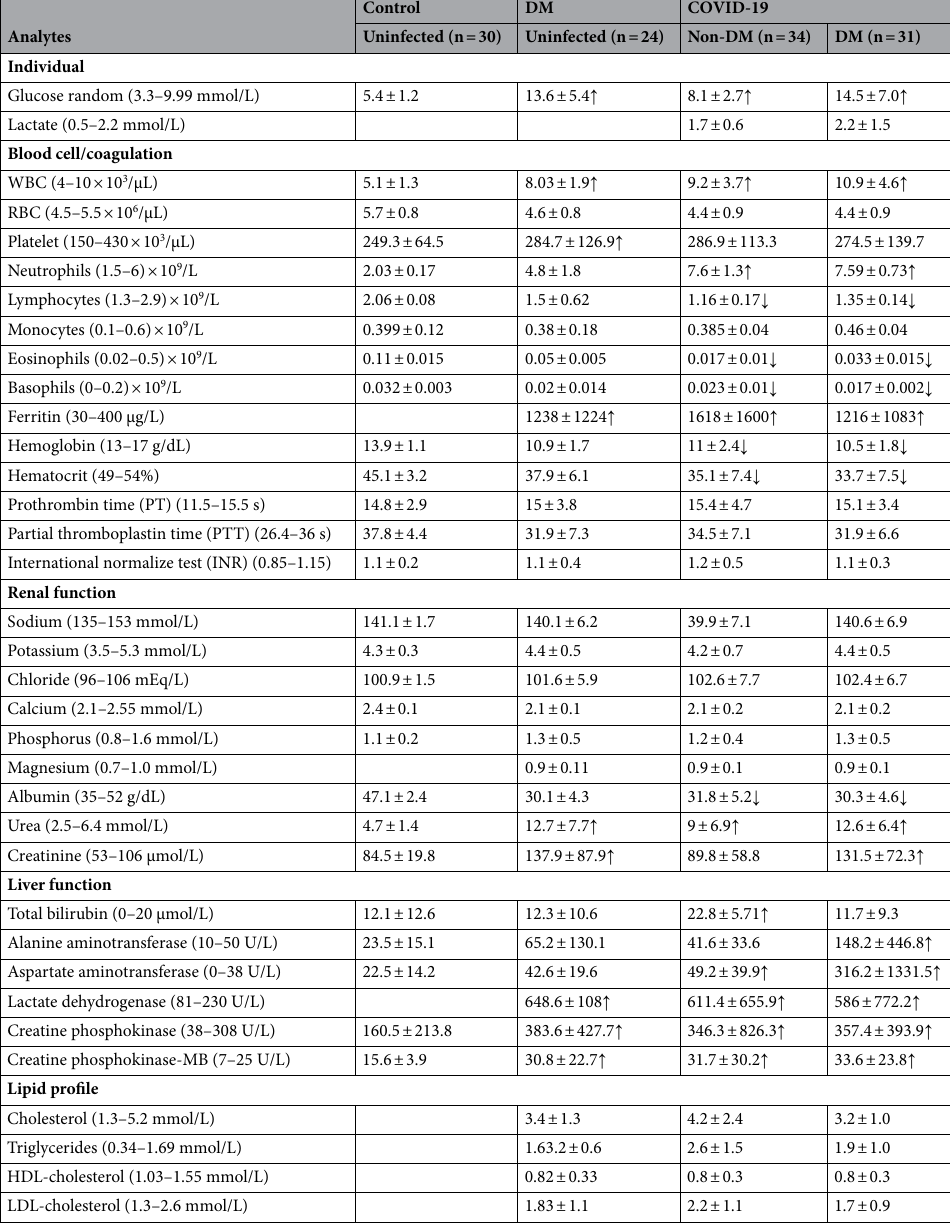
Table 2. Analytes in blood of uninfected (control and DM) and ICU COVID-19